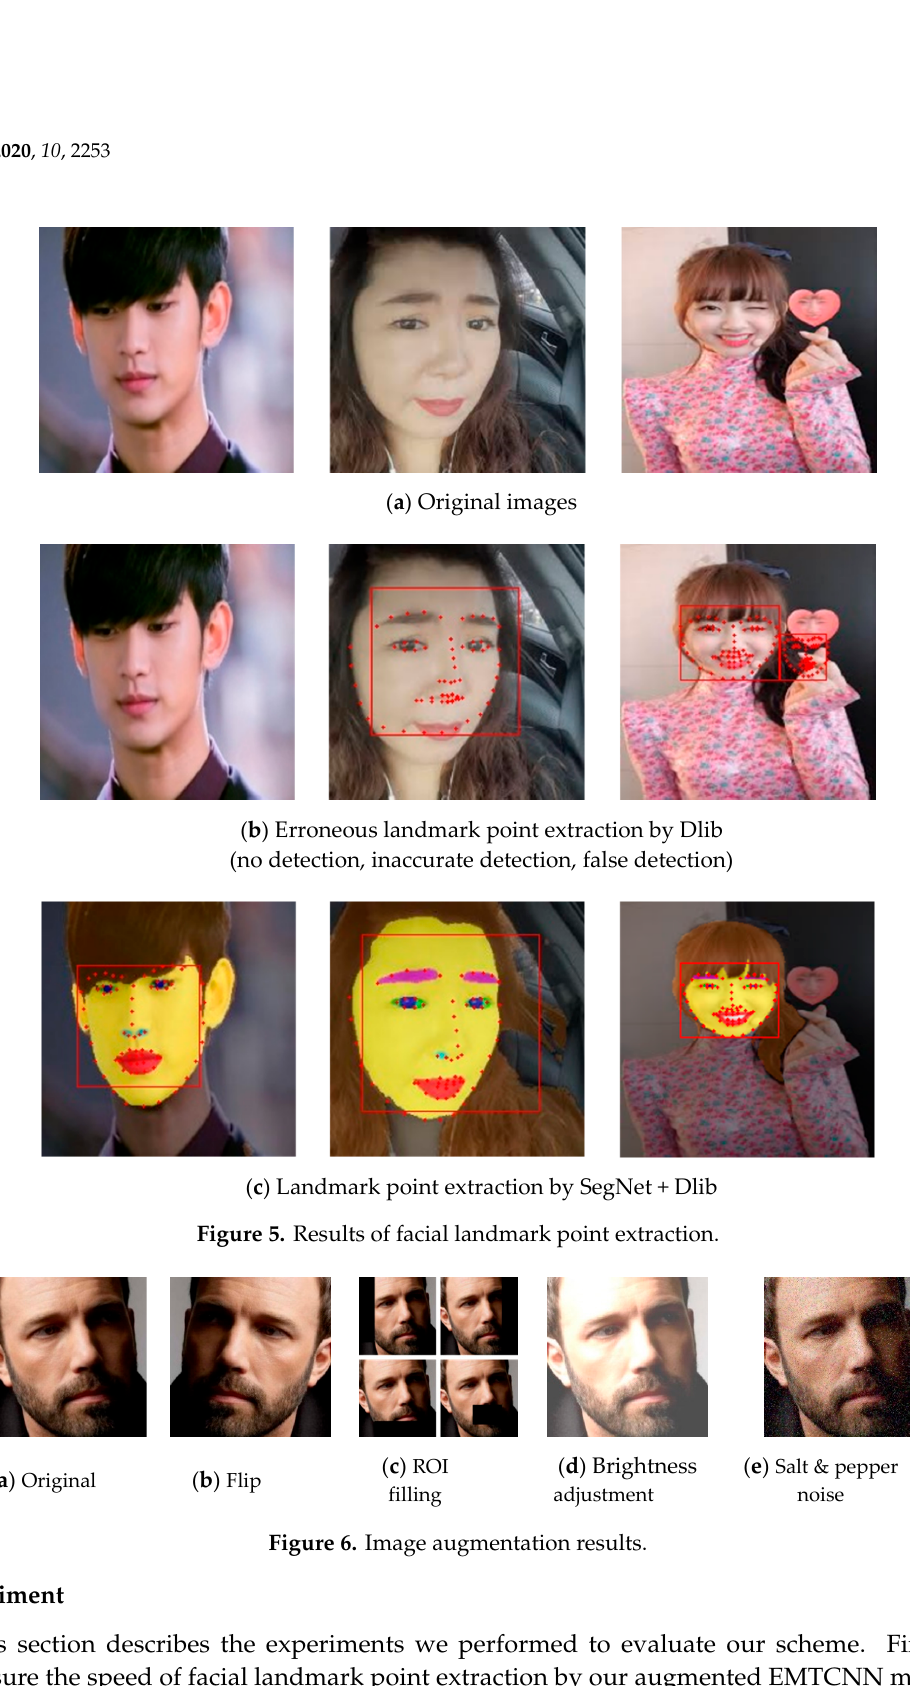
Table 2. Image dataset augmentation.